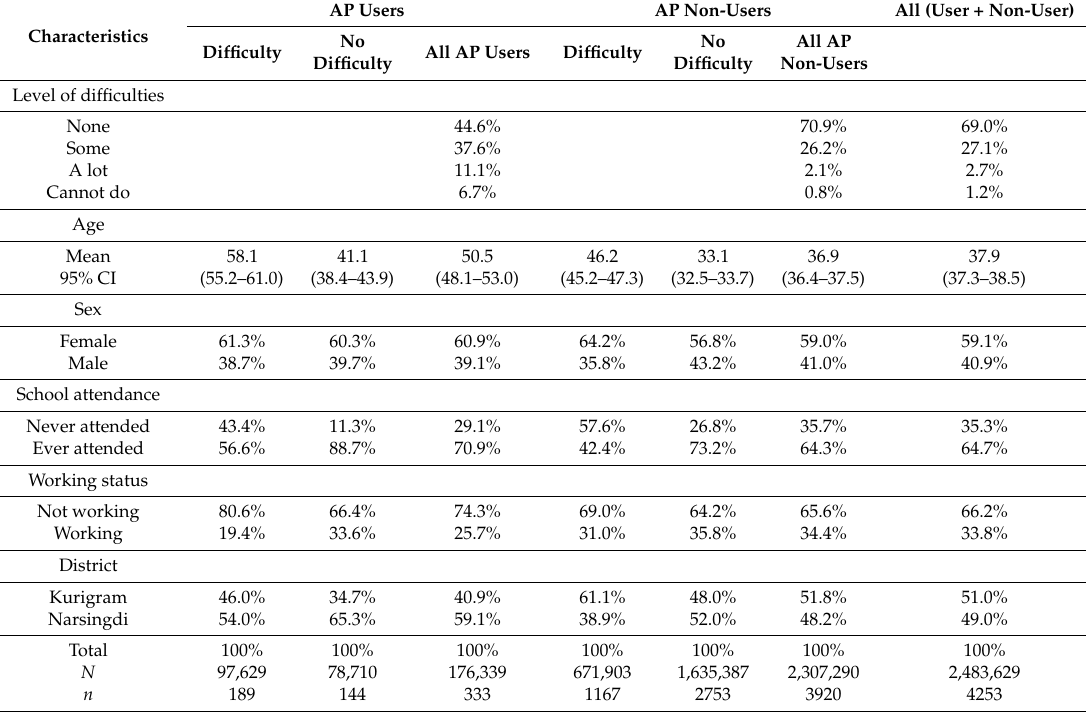
Table 1. Characteristics of assistive products (AP) users and